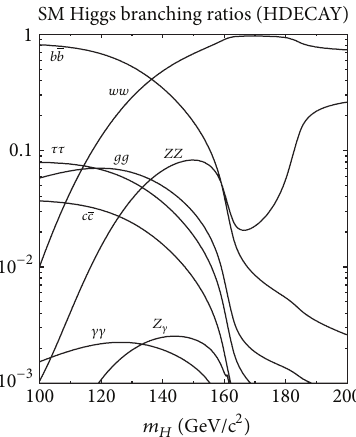
Figure 3: The branching ratio of Higgs boson decay modes in the Standard model (from